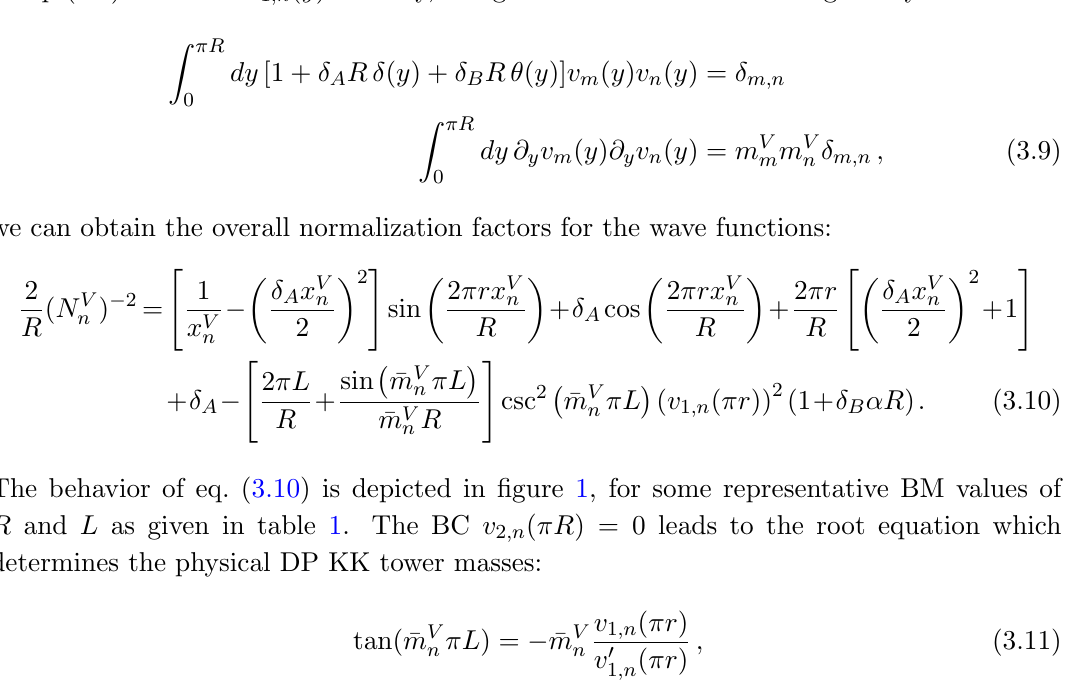
and the solution as n